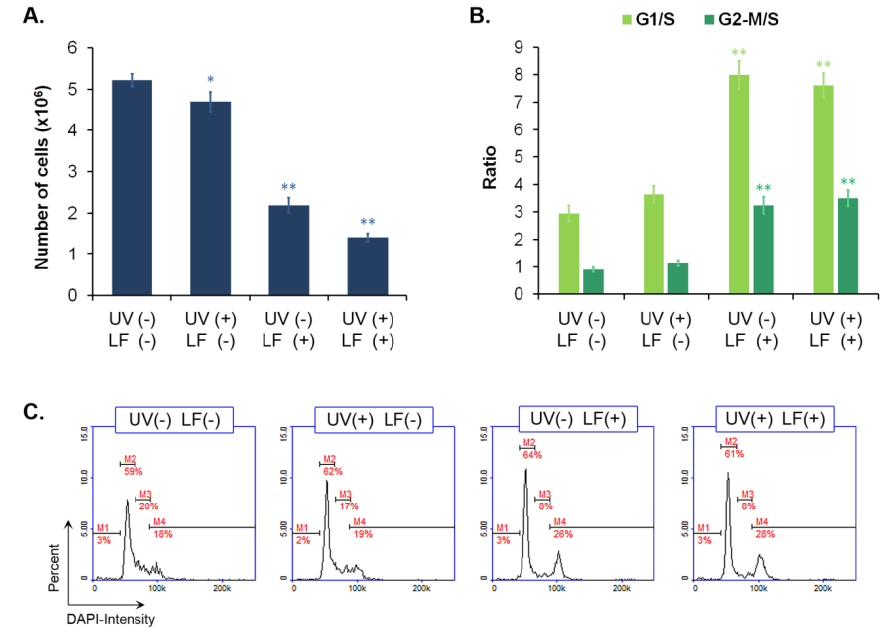
Figure 2. Lomefloxacin alone and in addition to UVA radiation causes the inhibition of fibroblast proliferation affecting the cell cycle. Cell number ( A ) and cell cycle ( B,C ) analyses were performed using lomefloxacin (LF) in the concentration of 0.5 mM and UVA radiation at a dose of 1.3 J/cm 2 . The presented histograms are representative of three independent experiments. Marked cell cycle phases: M1 – sub-G1 phase; M2 – G1/G0 phase; M3 – S-phase; M4 – G2/M phase. * p < 0.05, ** p < 0.01 vs. control.